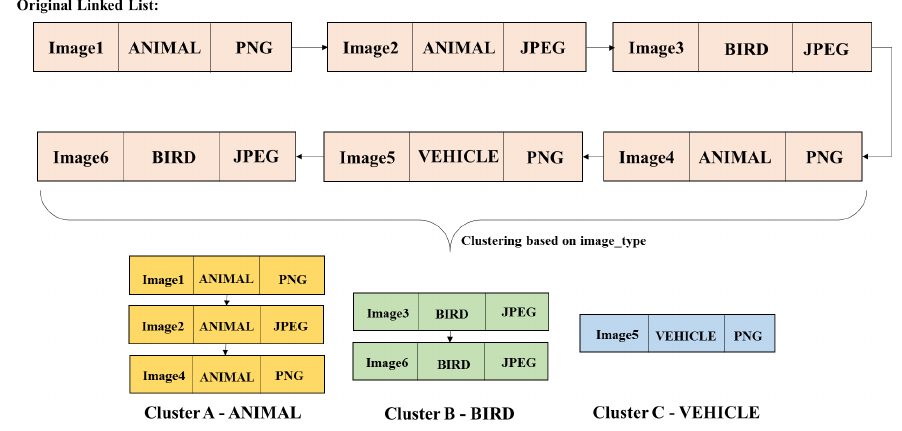
Figure 6. Clustering the image metadata using attribute-image_type.